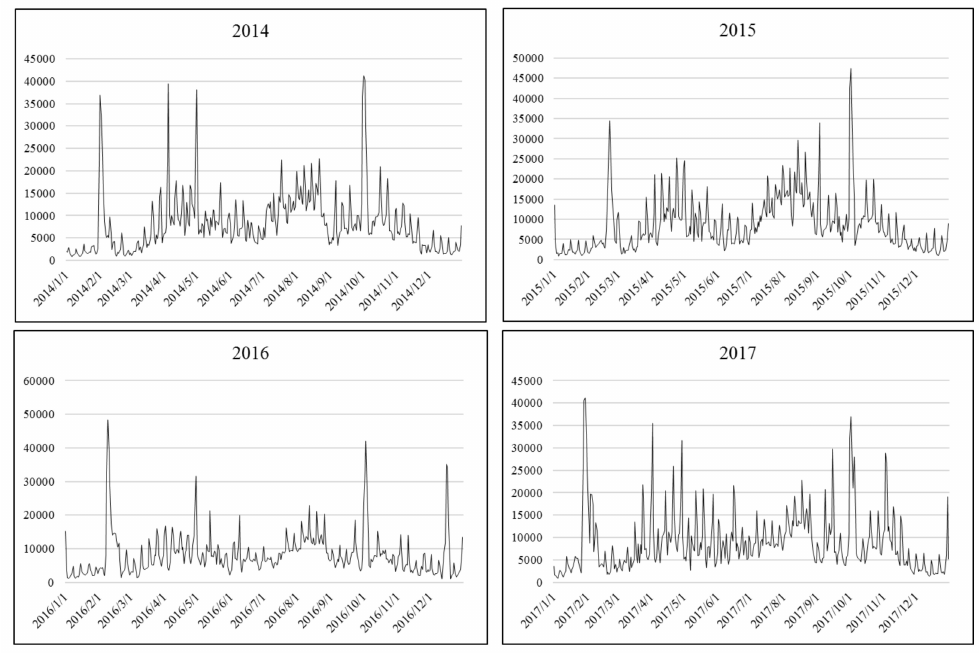
Figure 2. Daily tourist flow at Mountain Huangshan during 2014–2017.